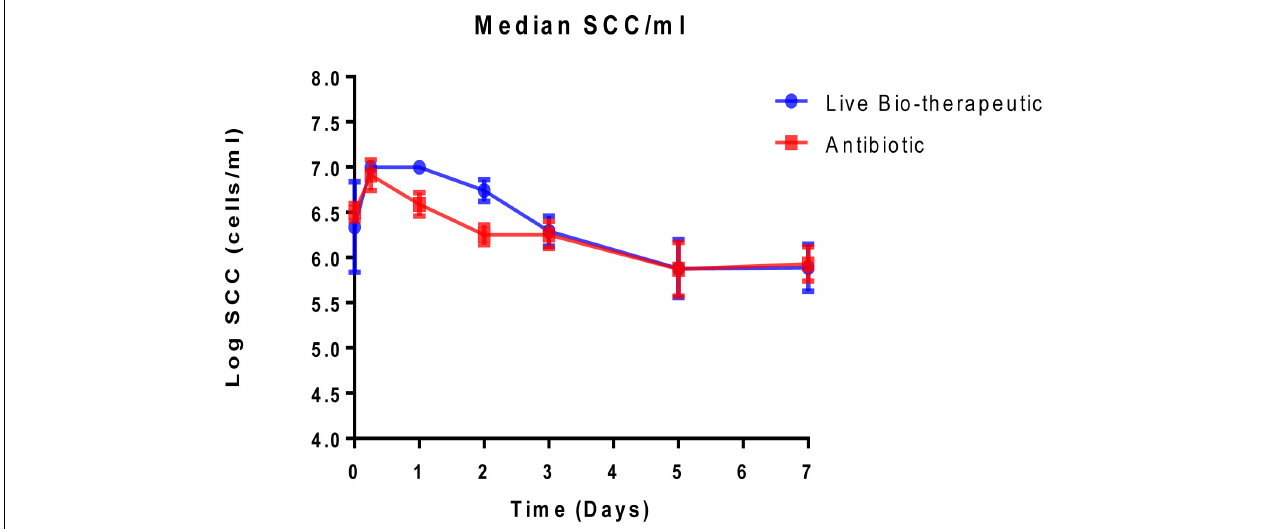
FIGURE 3 | Median log somatic cell counts/ml in milk samples from groups of cows with mastitis treated with either the “live bio-therapeutic” formulation or the commercial antibiotic. Determination of SCC from milk samples obtained from cows treated with either the “live bio-therapeutic” emulsion or the commercial antibiotic. Error bars represent standard error for each of the treatment groups.